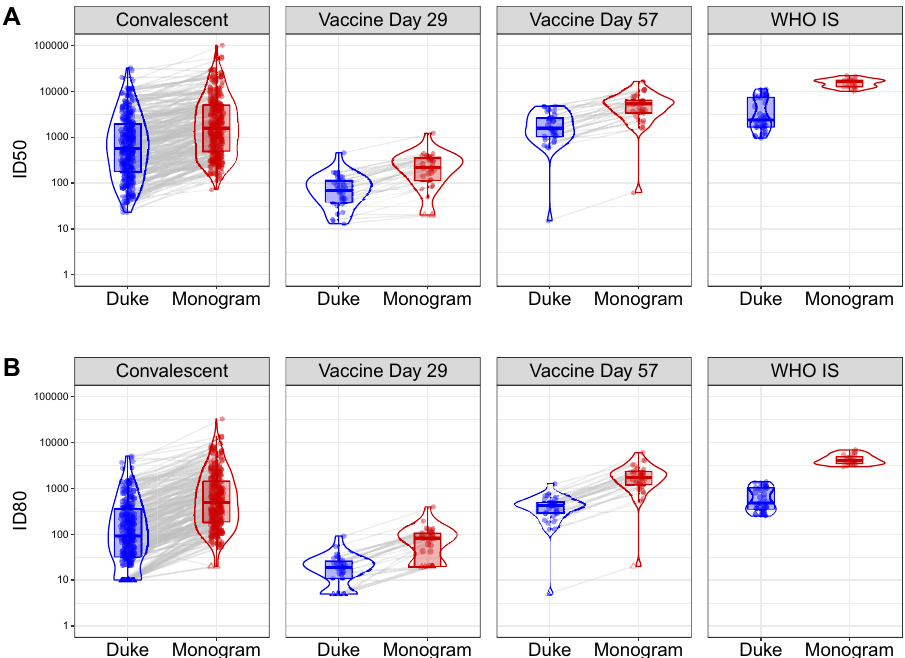
Figure 1. Distributions of pre-calibration ID50 (Panel A ) and ID80 (Panel B ) titers measured by the Duke and Monogram labs of convalescent patient samples, vaccine recipient samples, and the WHO International Standard sample. For the convalescent samples, the assay lower limit of detection (LLoD) is set at 20 for Duke and 40 for Monogram, the reciprocal of the starting dilution of each assay (these titers are also considered as the positivity cutoff values). For the vaccine samples collected at Day 29 and Day 57, 4 weeks post the first and the second Moderna doses, respectively, and the WHO I.S. sample, the assay LLoD is set at 10 for Duke and 40 for Monogram, the reciprocal of the starting dilution of each assay (these titers are also considered as the positivity cutoff values). Circle-shape points indicate titers > LLoD; triangle-shape points indicate titers ≤